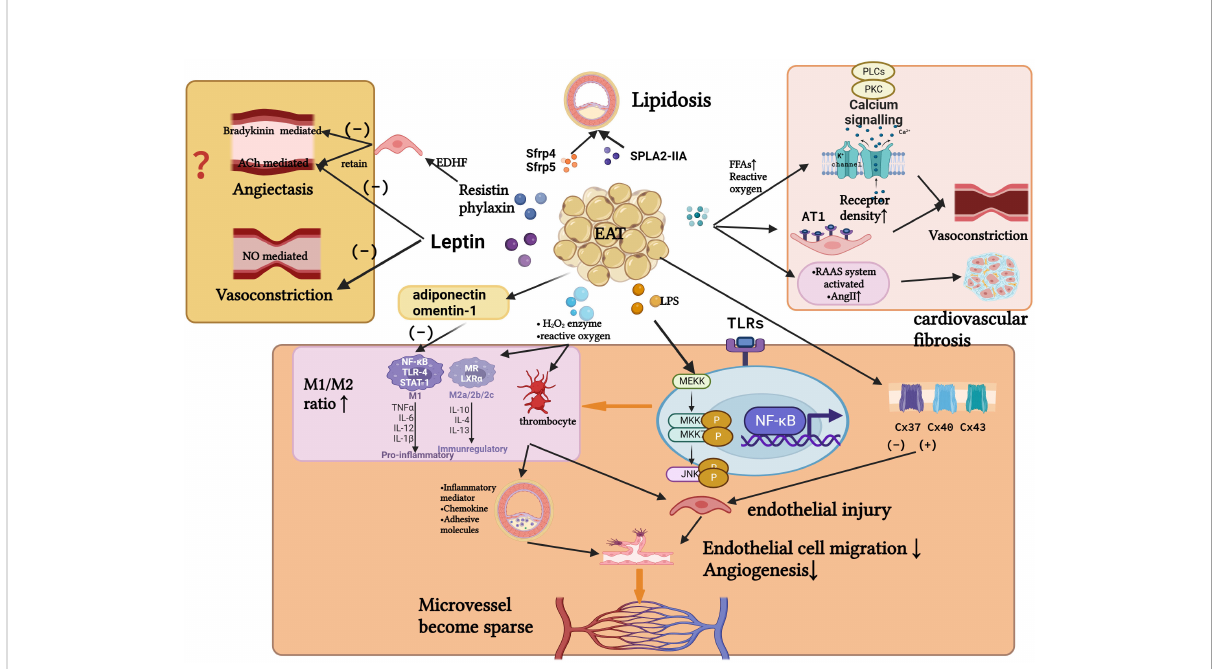
FIGURE 3 Several possible relationships between in fl ammatory EAT and the pathogenesis of INOCA. In fl ammation causes EAT to secrete cytokines and adipokines, altering the function of the vascular endothelium and the phenotype of macrophages. In turn, it affects the function of vascular smooth muscle, the remodeling of microvascular density, deposition of subcutaneous plaque lipids, and the mesenchymal fi brosis. These may affect perfusion of myocardial blood fl ow, leading to the development of INOCA. (Created with